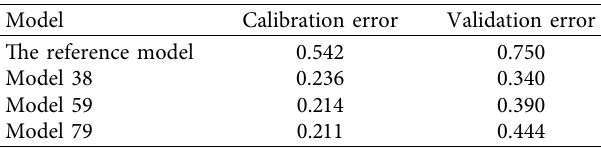
Table 4: Goodness-of-fit errors for the reference model and the three credible GP